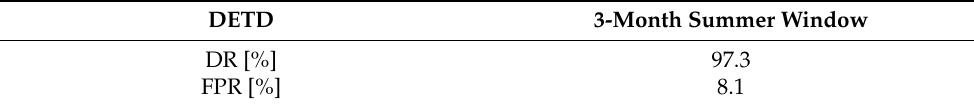
Table 4. Average theft detection performance of DETD when using the weather-dependent theft cases for an average of 1000 consumers (trained and tested on 3-month data).